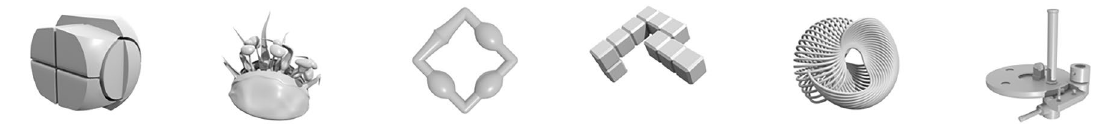
Figure 3. Example of object classes in an easy one-shot learning trial. The differences between classes are more pronounced, allowing for relatively easy discrimination of the defining features of each class.